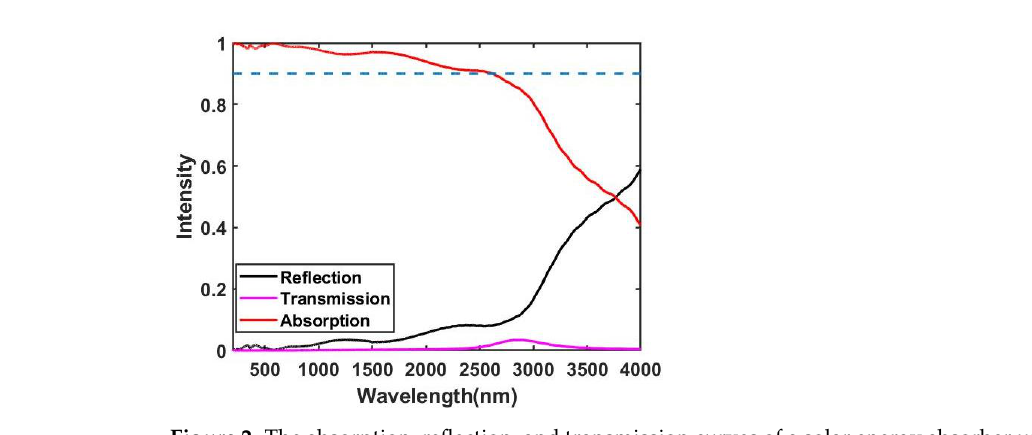
Figure 2. The absorption, reflection, and transmission curves of a solar energy absorber under normal